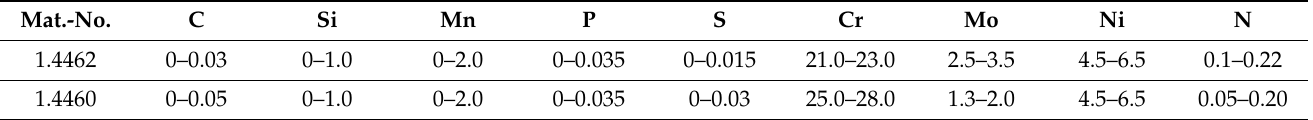
Table 1. Chemical composition of the 1.4462 [29] and 1.4460 [28] duplex steels according to